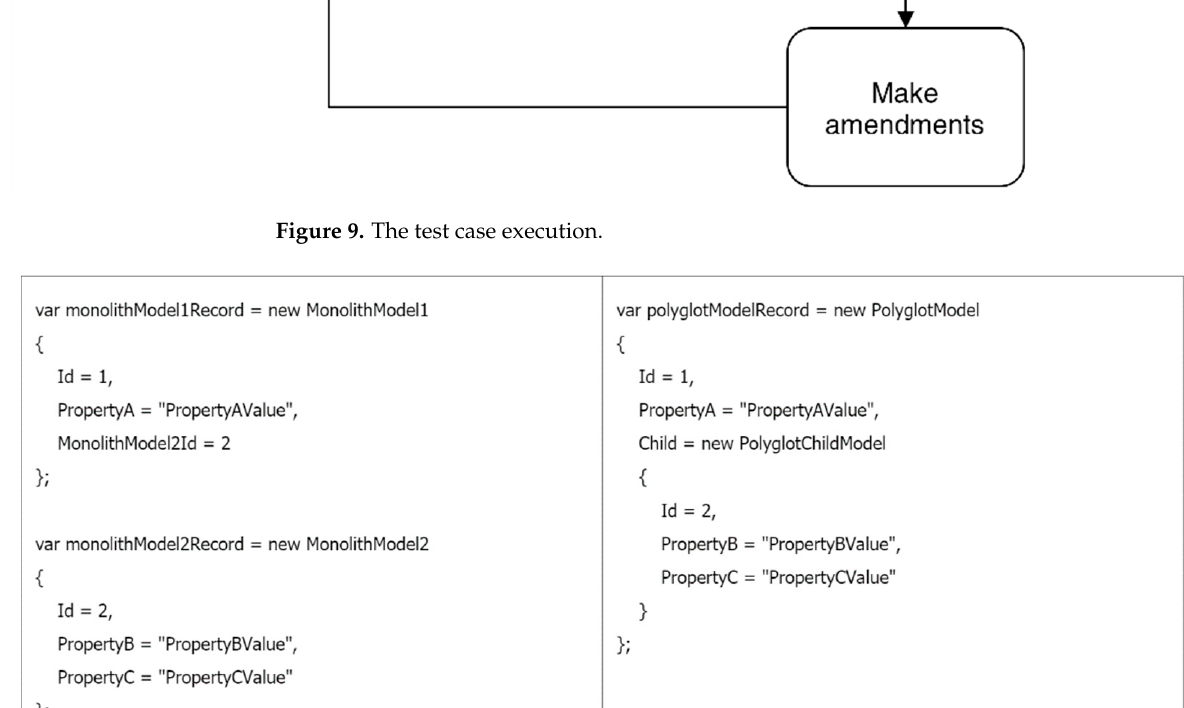
Figure 10. An example of the data records in the monolith database and multi-model polyglot persistence.